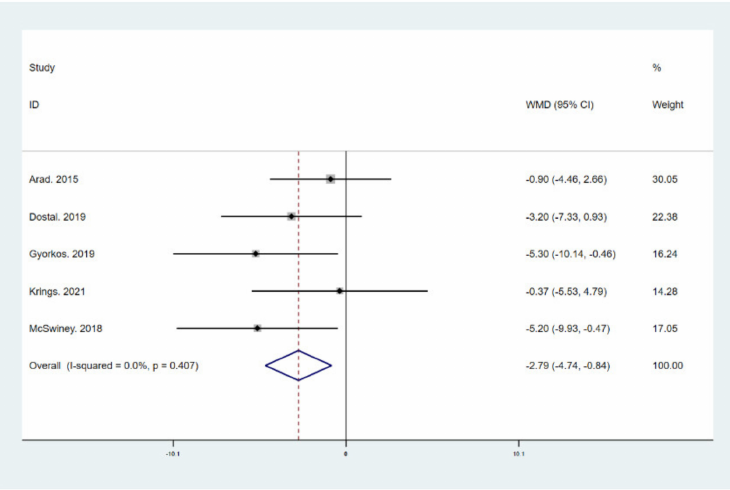
Figure 6. Forest plot for the effect of a low-carbohydrate high-fat (LCHF) diet combined with HIIT on body fat percentage (BFP). For each study, squares represent the mean difference in intervention effects, with horizontal lines intersecting them as the lower and upper limits of the 95% CI. The size of each square represents the relative weight of the studies conducted in the meta-analysis. The diamond represents the results of the meta-analysis combining the individual